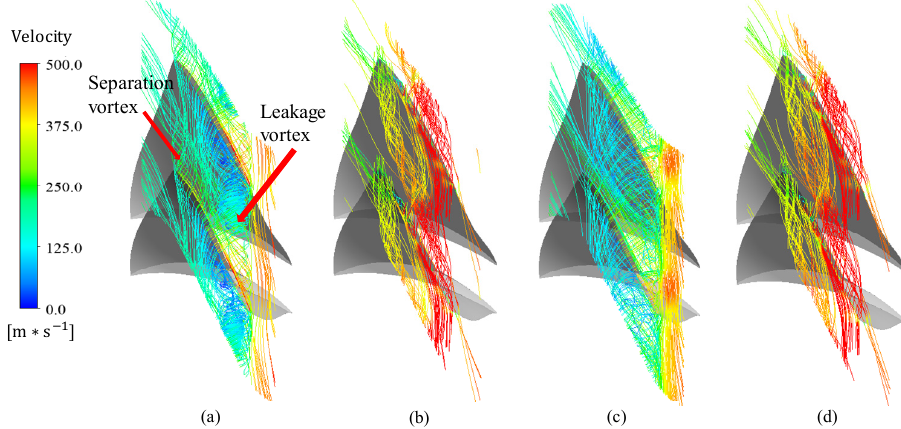
Figure 6. Streamlines at the blade tip. ( a ) ORI; ( b ) SES; ( c ) SEI; ( d ) CCT.